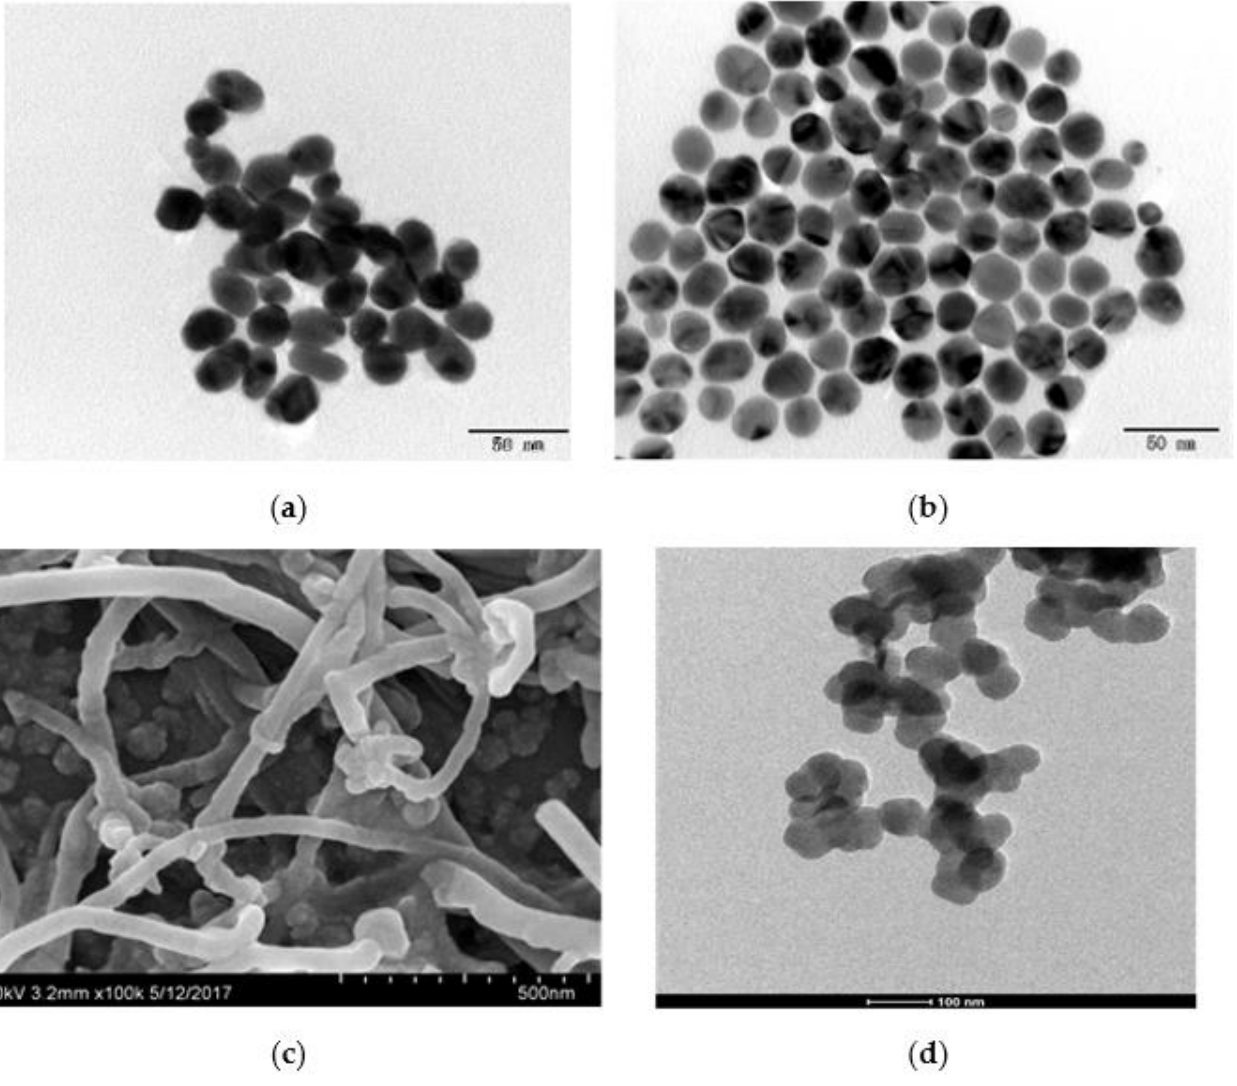
Figure 2. TEM images of nanofluids. ( a ) Au; ( b ) Ag; ( c ) MWCNT; ( d ) SiO 2.